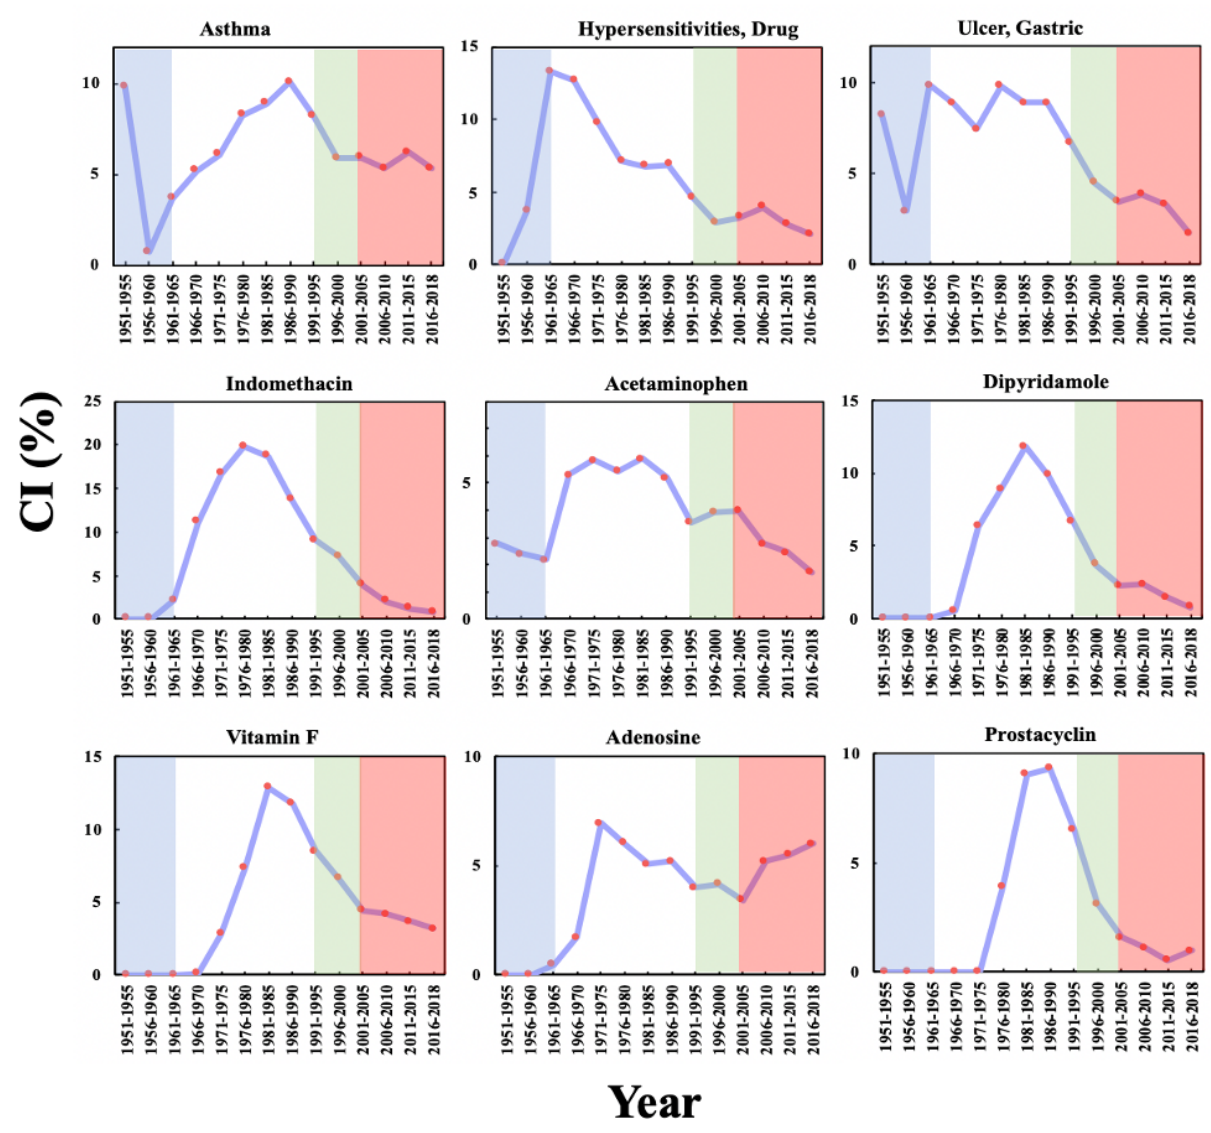
Figure 6. Collaboration Index (CI) of the biomedical entities on the pharmacological mechanisms and side effects of aspirin over time. The background colors show the 4 phases of aspirin